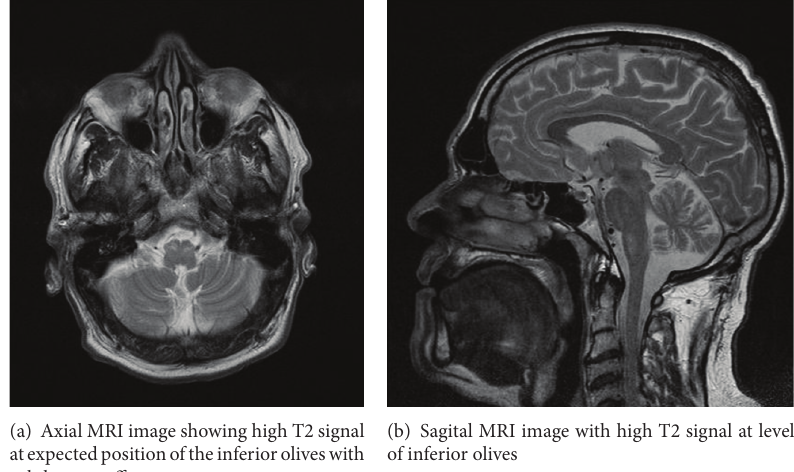
Figure 2: Isolated bilateral ION enlargement without accompanying brainstem or cerebellar